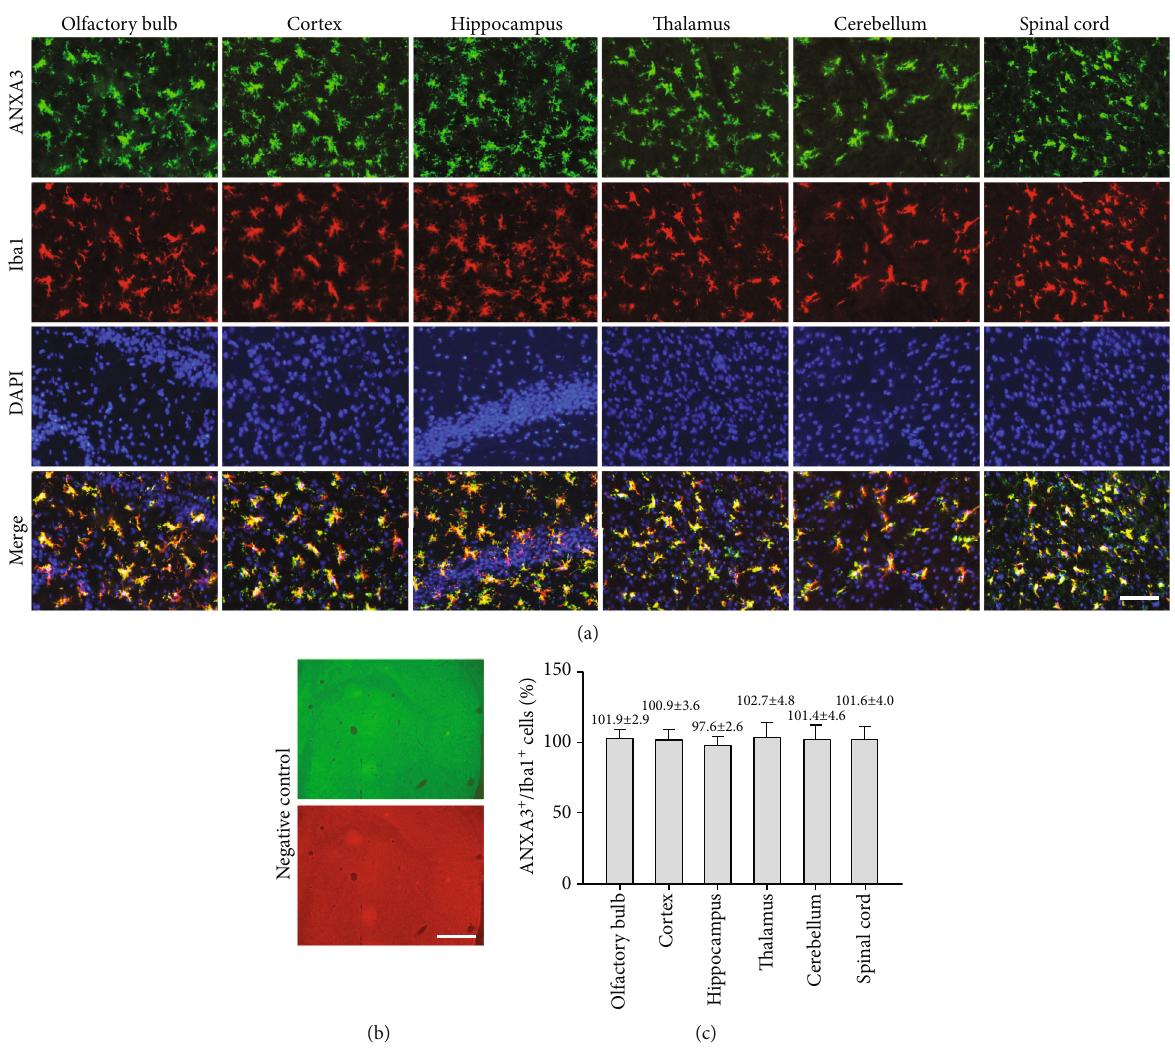
Figure 4: Colocalization of ANXA3 and Iba1 in di ff erent regions of the CNS. (a) Representative immuno fl uorescence images of microglia labeled by ANXA3 and Iba1 in the olfactory bulb, cortex, hippocampus, thalamus, cerebellum, and spinal cord of adult rats (3 months). Scale bar = 40 μ m . (b) Images of the negative control (without primary antibody). Scale bar = 100 μ m . (c) Quantitative analysis of ANXA3 + /Iba1 + microglial cells in di ff erent regions of the CNS. The data are presented as the means ± SD and were analyzed by one-way ANOVA with Tukey ’ s post hoc test. n = 5 per group. Cells in fi ve randomly selected fi elds were